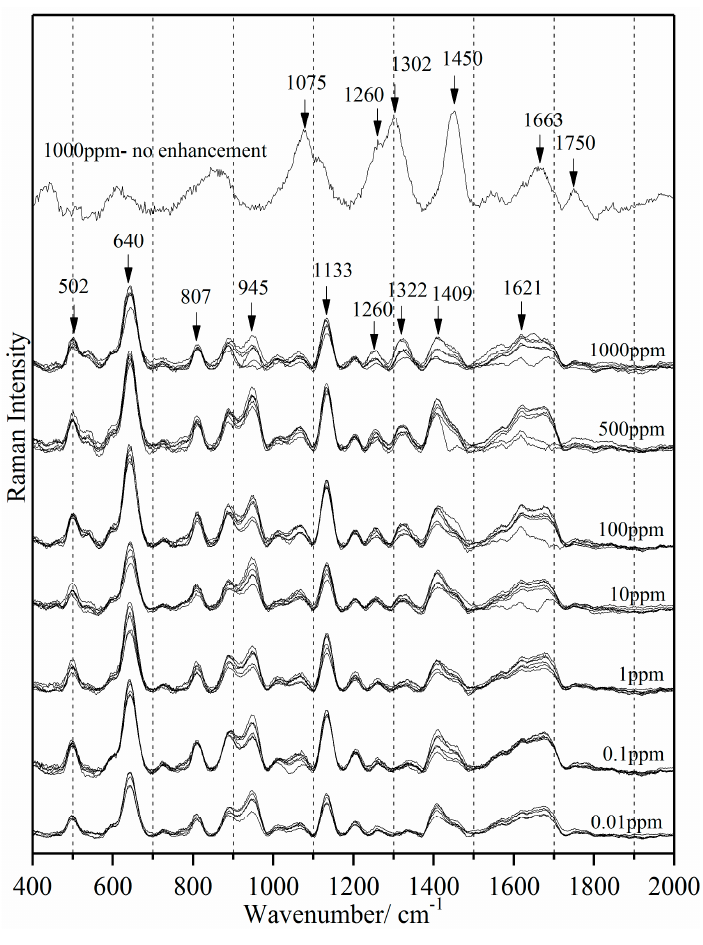
Figure 7. Surface-enhanced Raman spectra of milk-tetracycline solution at seven concentration levels.